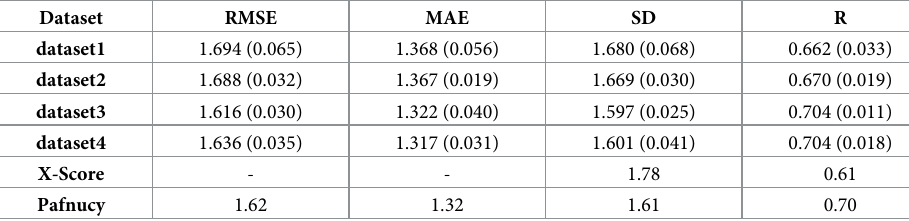
Table 4. The performance of GraphBAR with the PDBbind v.2013 core set.